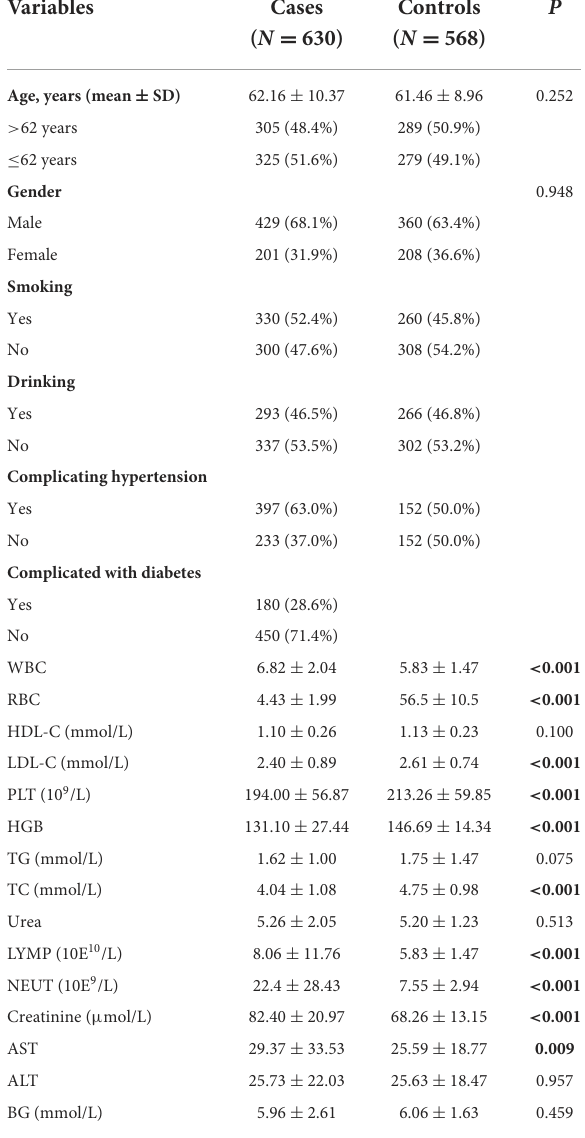
TABLE 1 Characteristic of patients with CHD and controls.